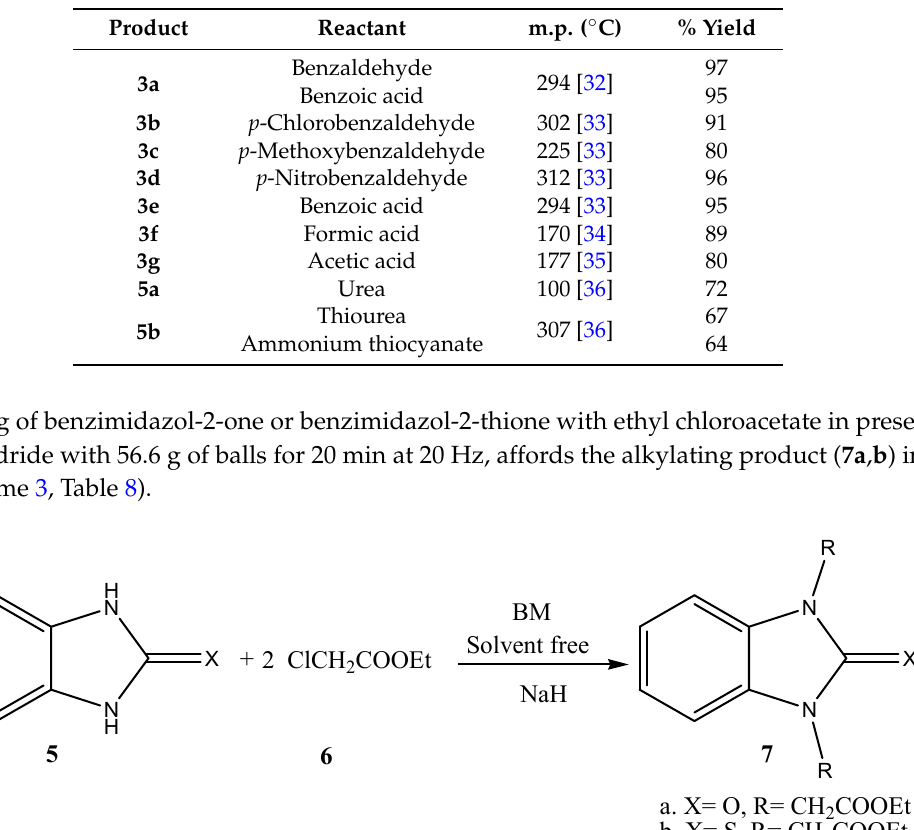
Table 7. Milling of 2.5 g of o-phenylenediamine and 3 g of aldehyde, carboxylic acids, urea or ammonium thiocyanate with 56.6 g of balls for 60 min at 20 Hz.